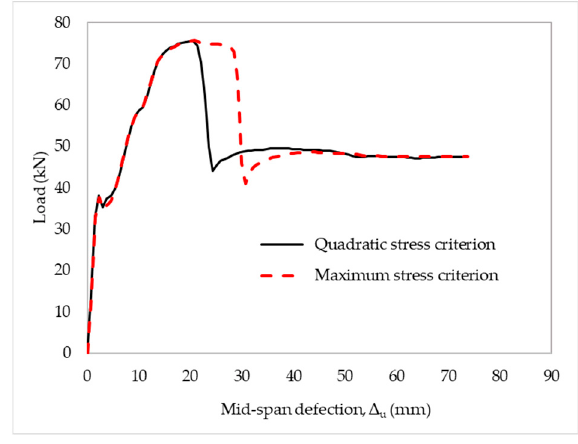
Figure 15. The effect of strengthened slabs on damage initiation criteria.